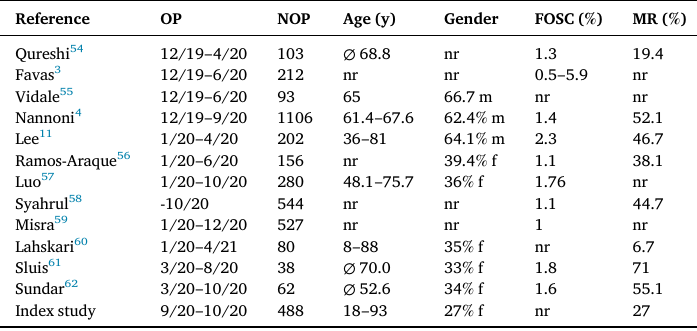
FOSC, Frequency of Stroke among COVID-19 patients; MR, Mortality Rate; NOP, Number of Patients with SARS-CoV-2 associated stroke; nr, Not Reported; uk, Unknown.